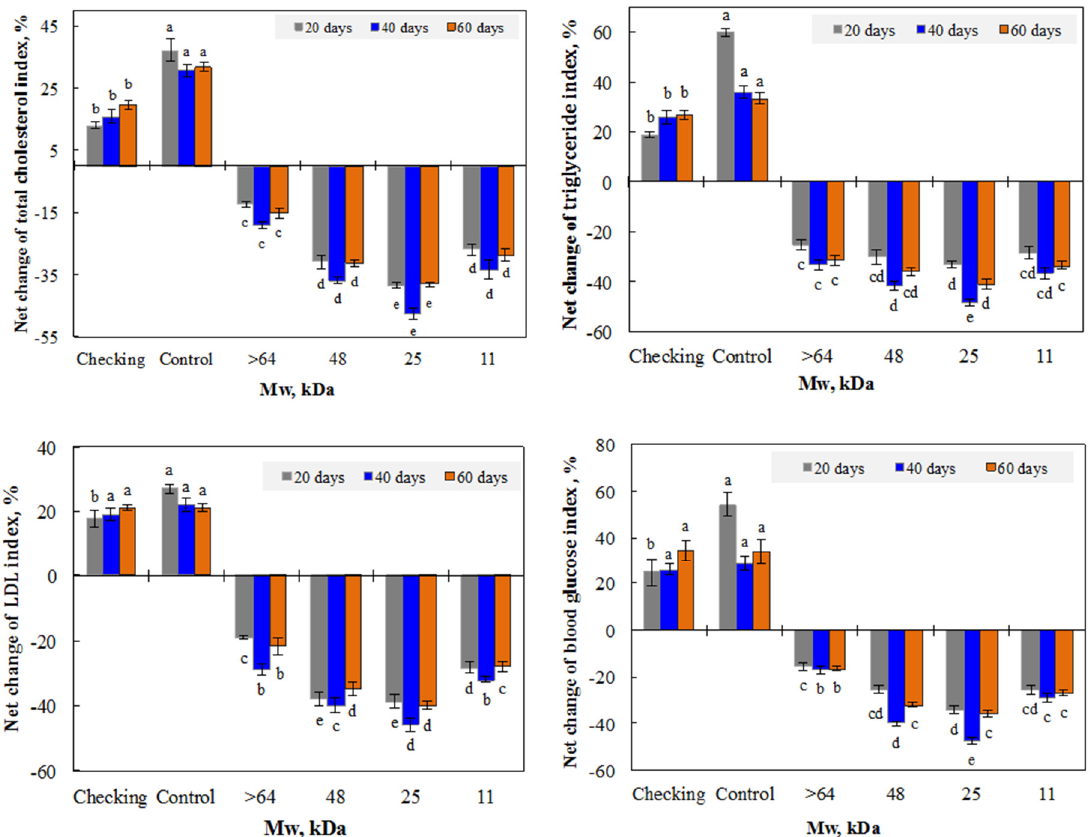
Figure 6. Net change of blood lipid and glucose indexes of mice after 20 and 40 days administrating with unirradiated and irradiated β -glucan samples, and after stopping administration for the following 20 days (60